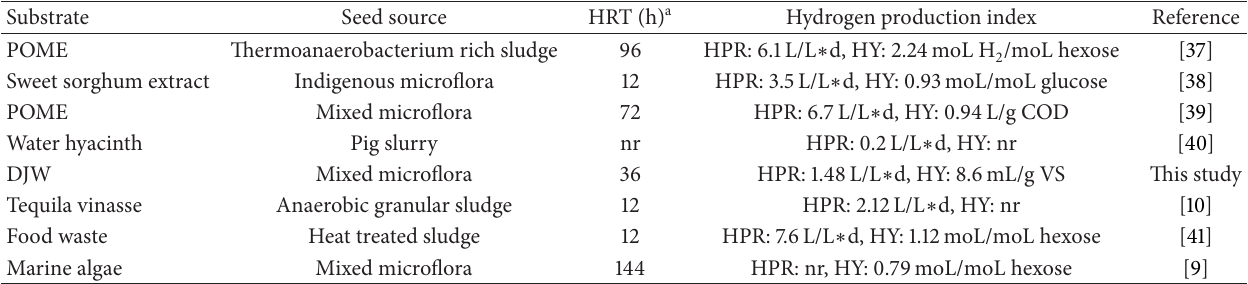
Table 6: Comparison with other cellulosic materials operated via ASBR